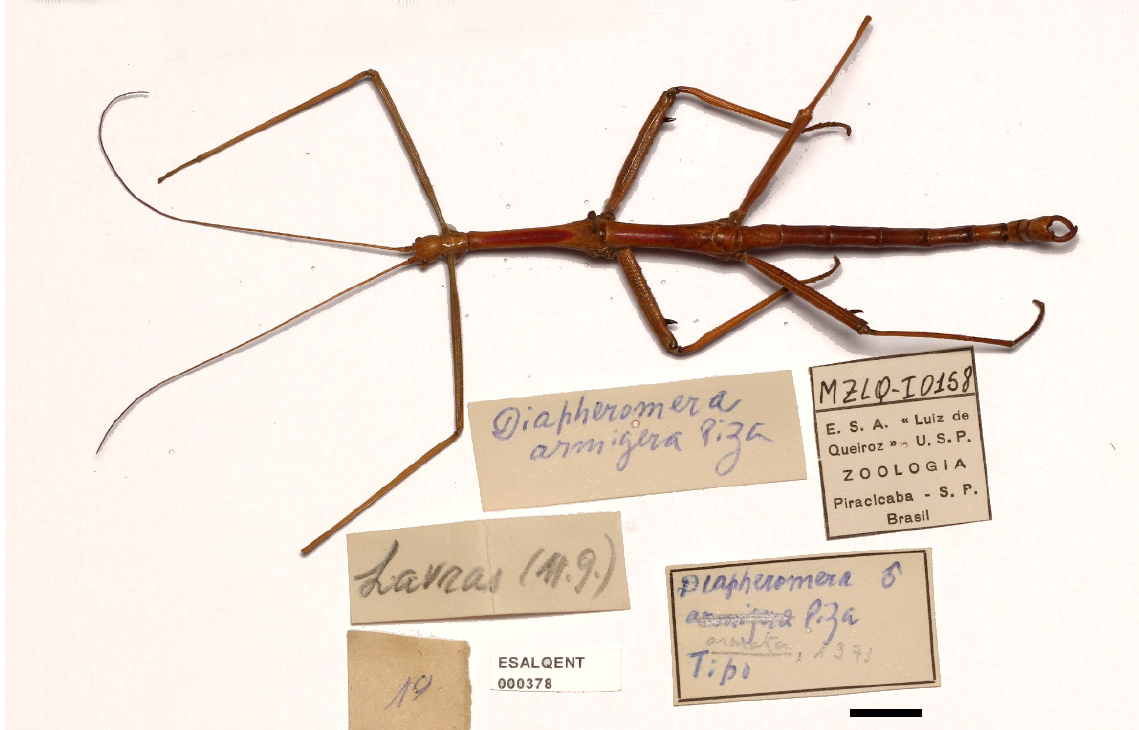
Fig. 54. Holotype of Diapheromera armata Piza, 1973 at MELQ and accompanying labels. Note that the specific epithet was written as armigera on one of the labels but later corrected by pencil to the published name. Scale bar: 10